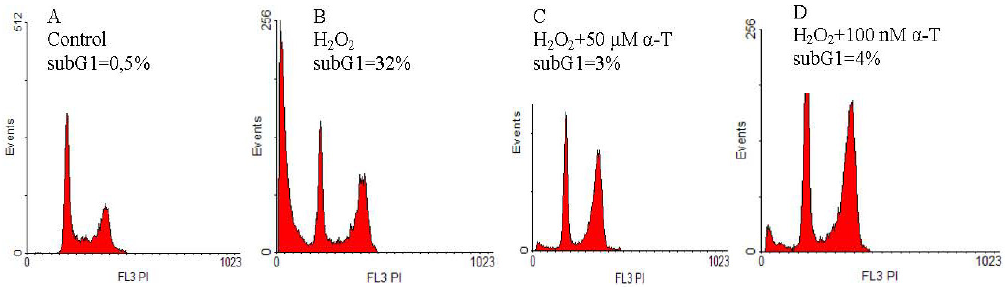
Figure 5. The figure shows the effect of pre-incubation for 18 h with α -T, prior to PC12 O for 24 h on the relative number of PC12 cells in late cell exposure to 0.2 mM H 2 2 apoptosis (% of the total cell number). The results of one typical experiment from 5 replicates are presented. The relative value of subG1 hypodiploid peak (left on the histograms) corresponds to the relative number of PC12 cells in late apoptosis. In the O ; ( C ) H O + pre-incubation with 50 μ M α -T; ( D ) H O + figure: ( A ) control; ( B ) H 2 2 2 2 2 2 pre-incubation with 100 nM α -T. In the control sample, the relative number of cells in late O increases this peak to 32% ( B ). apoptosis ( A ) is lower than 1%, but exposure to H 2 2 However, pre-incubation with 50 μ M and 100 nM α -T decreases the relative value of the subG1 hypodiploid peak from 32% ( B ) to 3% and 4% of the total cell number, respectively ( C , D